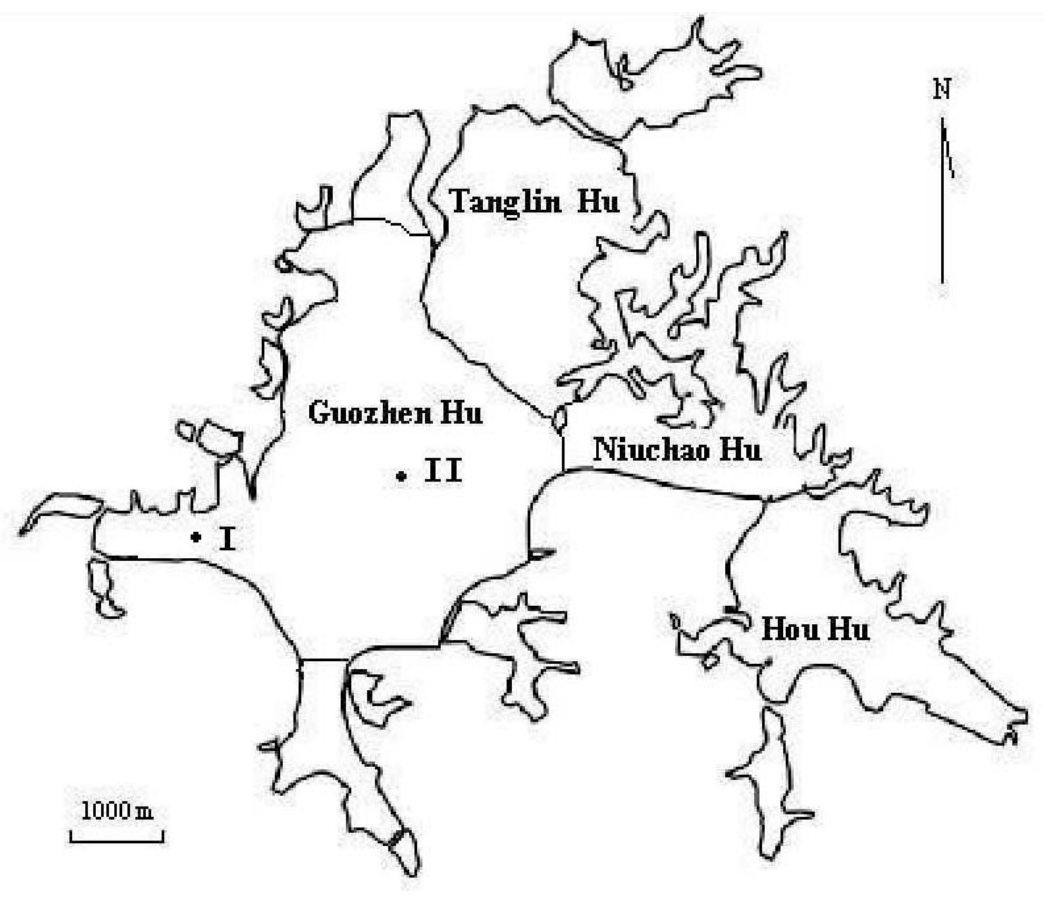
FIGURE 1. Map of Lake Donghu, P.R. China, showing major sections of the artificially divided